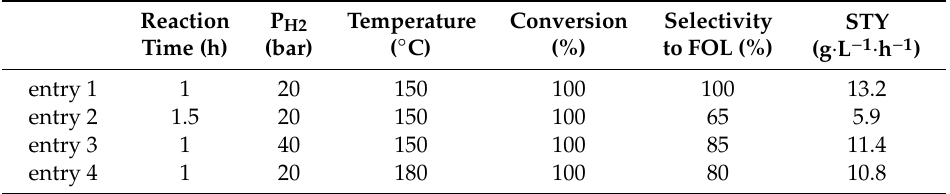
Table 2. Hydrogenation of furfural in a batch reactor 1 . FOL; furfuryl alcohol, STY; space time yield. Reaction